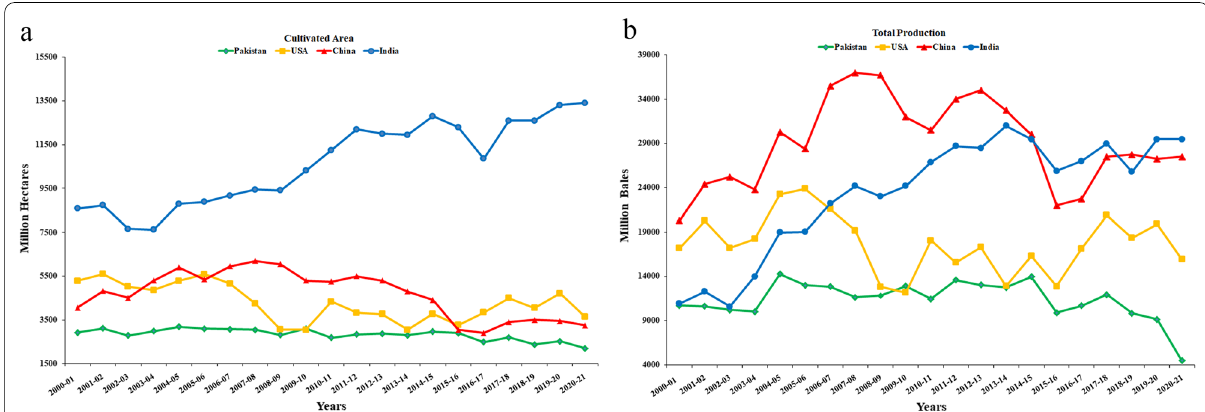
Fig. 1 Total cultivated area and production of cotton in Pakistan, China, USA, and India during 2000–2021. Source of data Cotton-statistics & facts (https:// www. stati sta. com/ topics/ 1542/